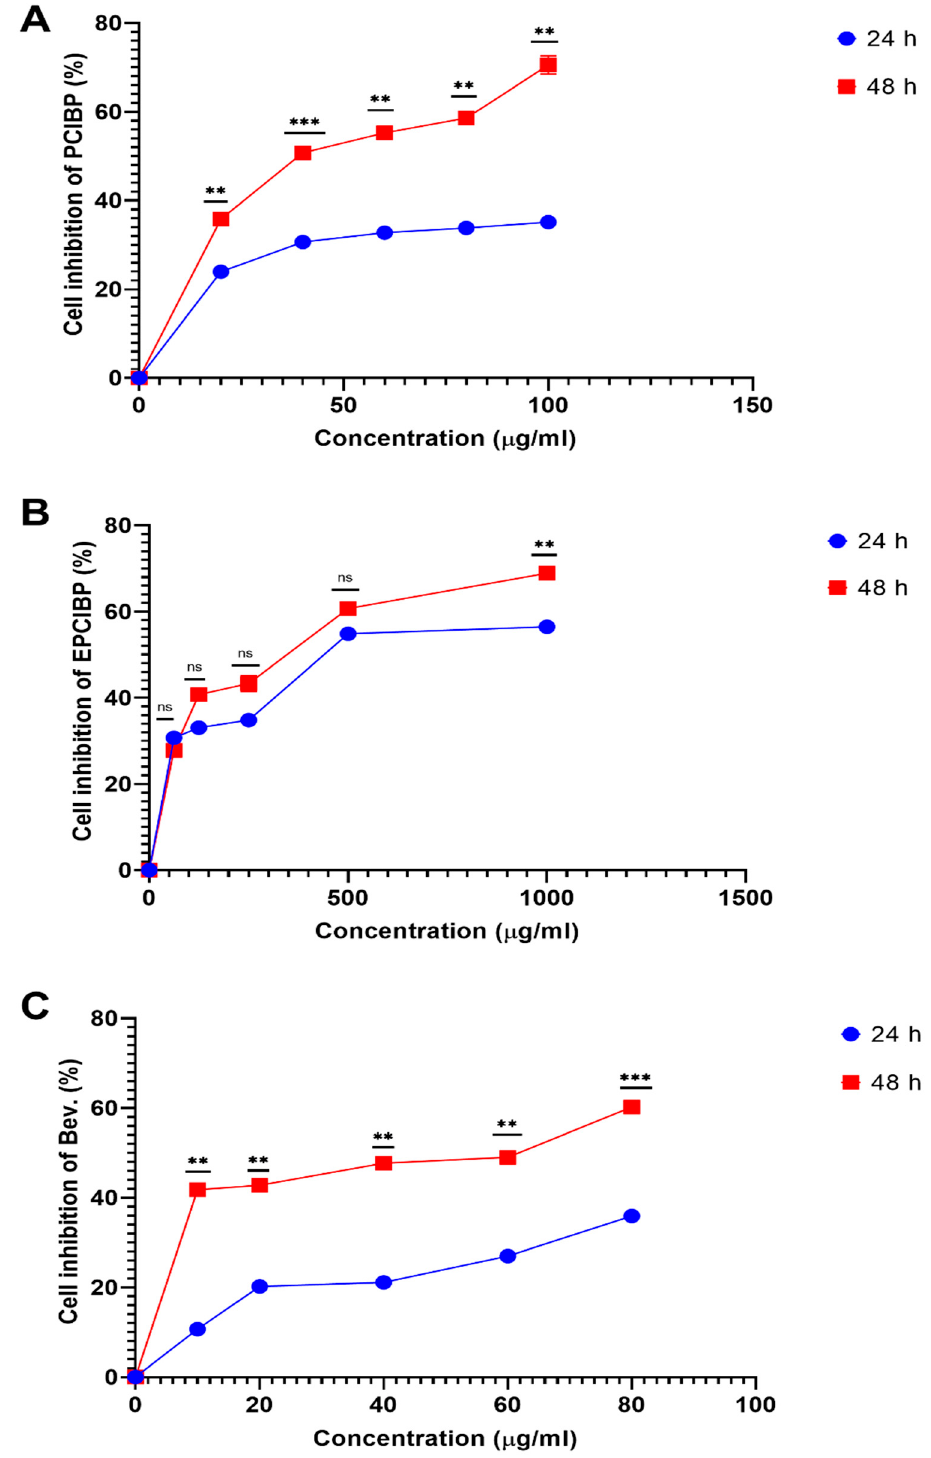
Figure 7. Line graph of the cell inhibition results on MCF7 breast cancer cells after incubation for 24 and 48 h with PCIBP, EPCIBP, and Bev. treatments. The percentage of treated cells was measured by MTT cytotoxicity assay. ( A ) PCIBP for each point compared with the other points by multiple t -tests where ** p ≤ 0.001, *** p ≤ 0.0001; ( B ) EPCIBP for each point compared with the other points by multiple t -tests where ns: nonsignificant, ** p ≤ 0.001; ( C ) Bev. for each point compared with the other points by multiple t -tests where ** p ≤ 0.001, *** p ≤ 0.0001.